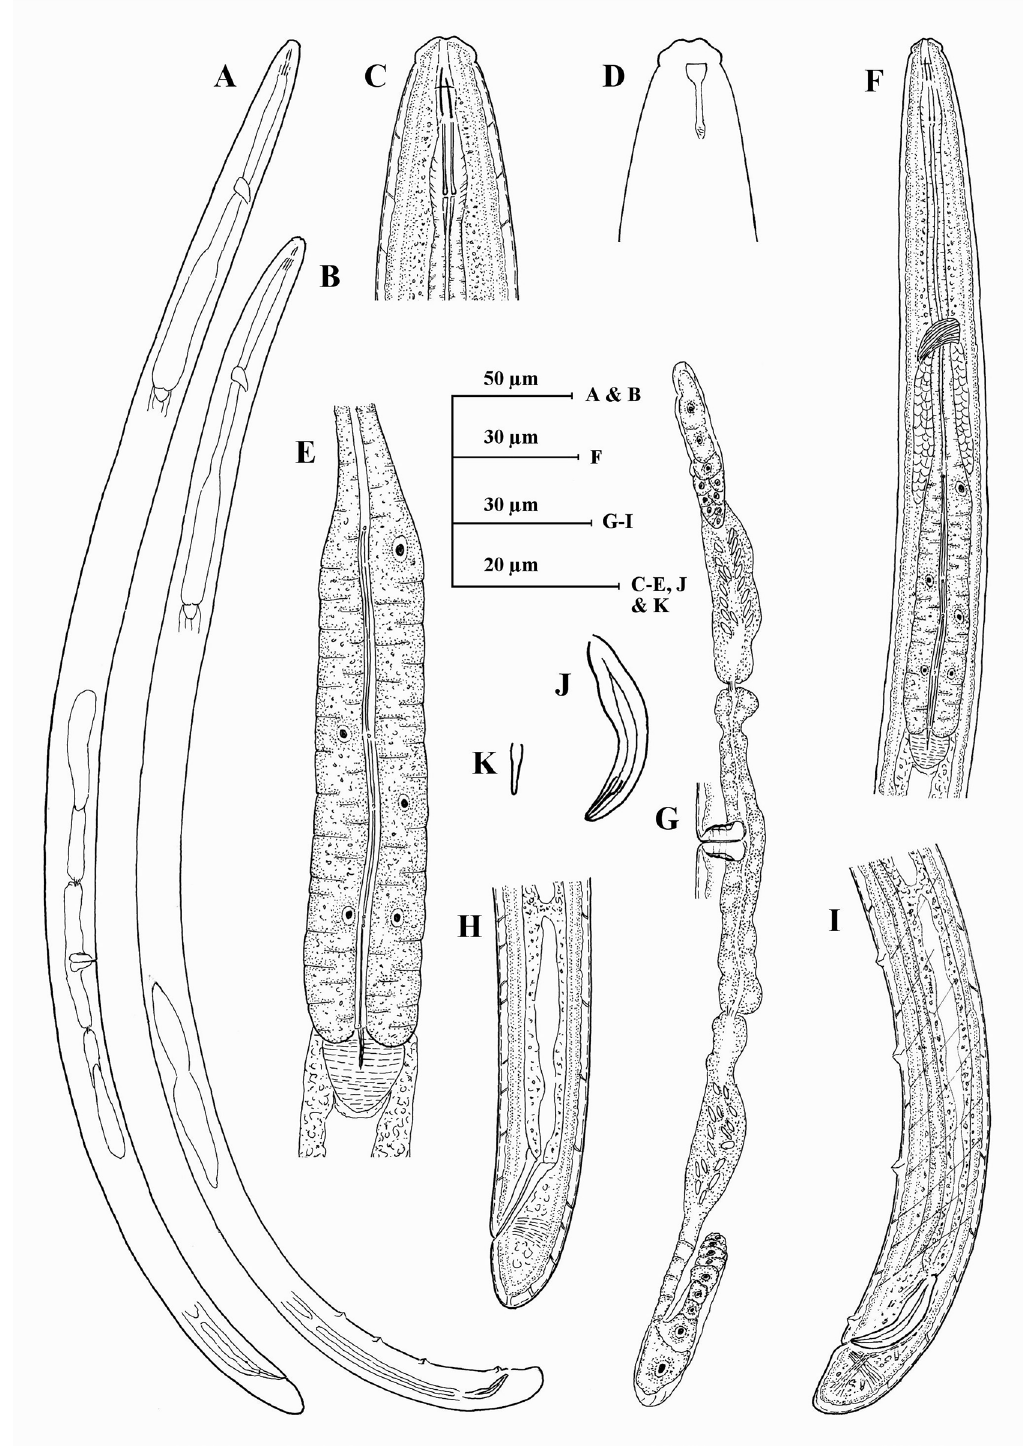
Fig. 9. Tylencholaimus shamimi sp. nov . A, G . Paratype 5, ♀ (slide 4). B, I–K . Paratype 6, ♂ (slide 5). C–F, H . Holotype, ♀ (AMU/ZD/NC/ Tylencholaimus shamimi /1). A . Entire female. B . Entire male. C . Female anterior region. D . Female anterior region showing amphid. E . Female expanded part of pharynx. F . Female pharyngeal region. G . Female genital system. H . Female posterior region. I . Male posterior region. J . Spicule. K . Lateral guiding